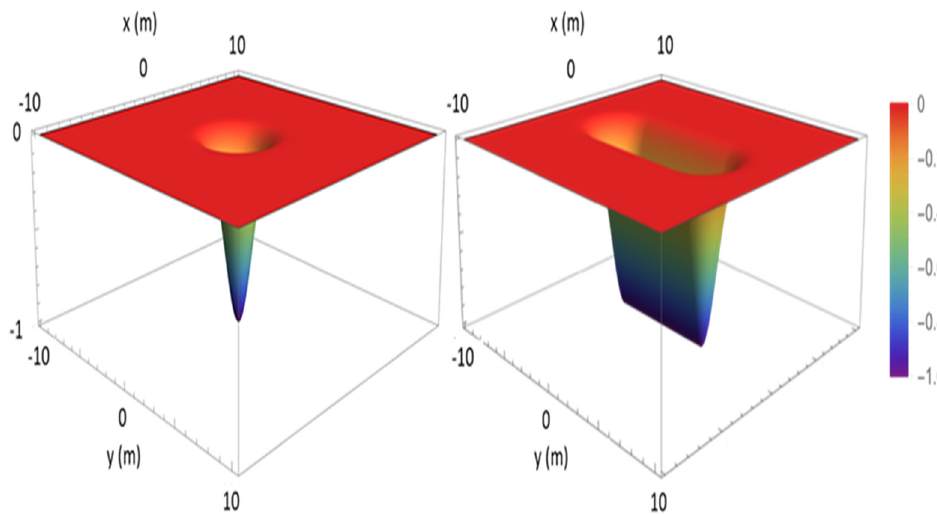
Figure 6. Pressure transient probability profiles for ( a ) point source (single well), and ( b ) interval source (fracture) using λ = 1. Fracture half-length is 4 m. Horizontal scale in m. Vertical scale is inverted probability (0 to − 1). For plotting, the reservoir pressure drop ∆ P 0 in Equation (24) is entered as a negative z -value.